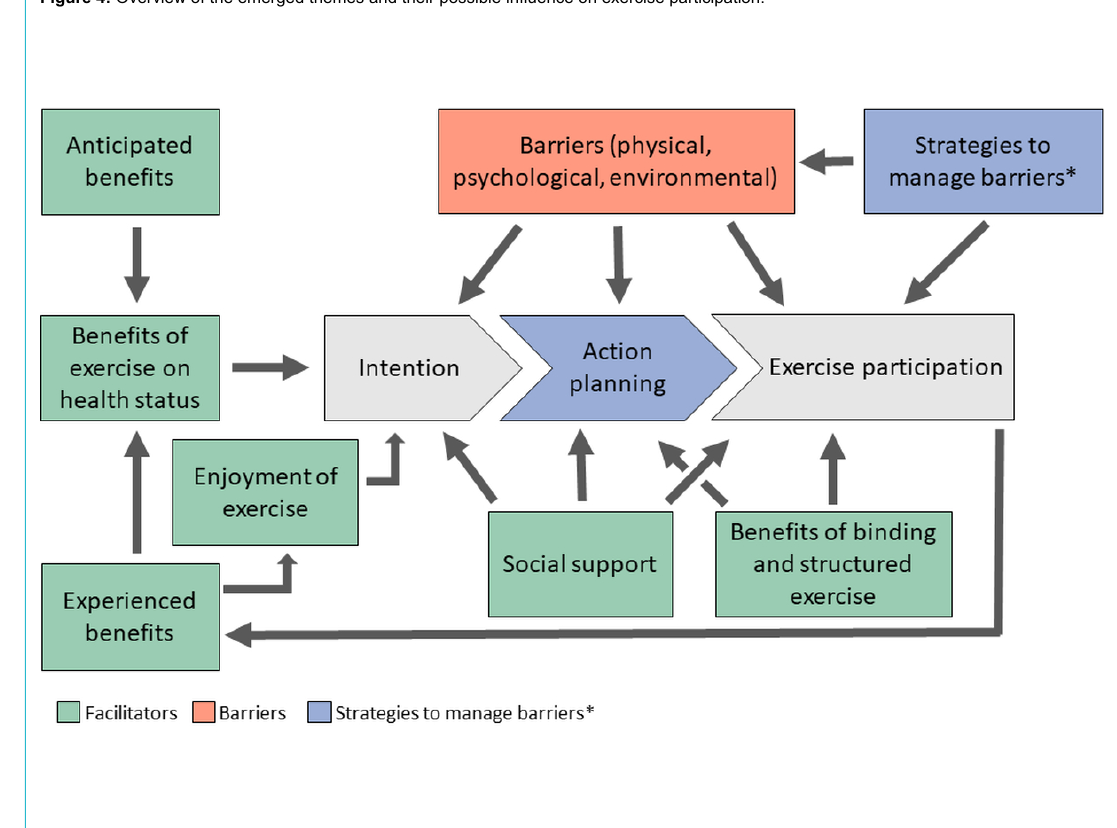
Figure 4: Overview of the emerged themes and their possible influence on exercise